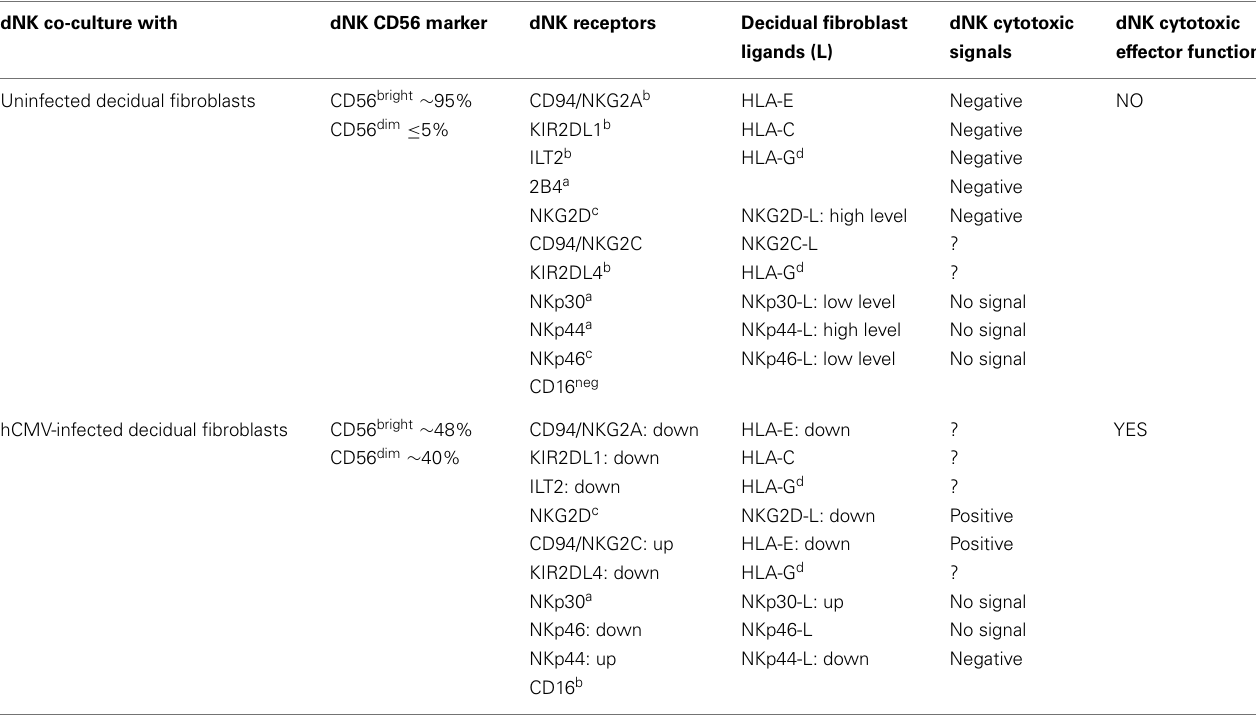
Table 1 | Decidual NK receptor-ligands interactions, signals and cytotoxic effector functions. dNK co-culture